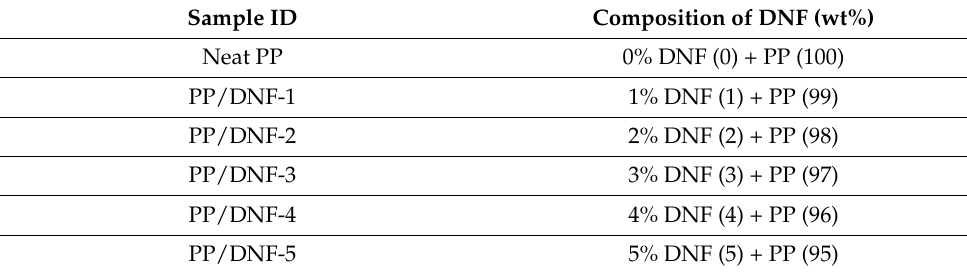
Table 1. List of PP/DNF composites produced in the present